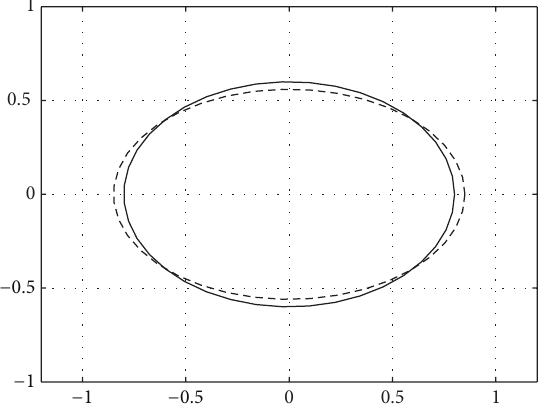
Figure 4: Case 1: 𝑡 = 0.40 , reconstruction of an elliptic curve.